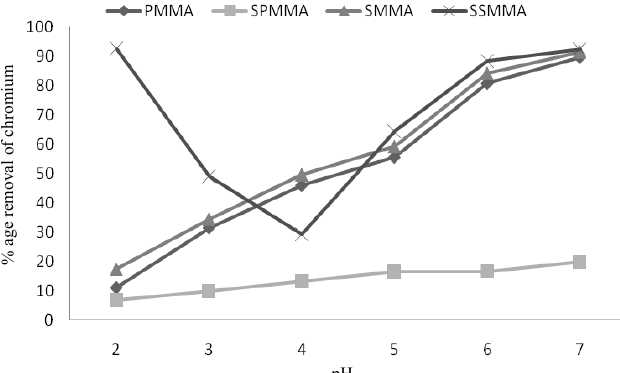
Figure 4. The effect of pH on adsorption of Cr(III)